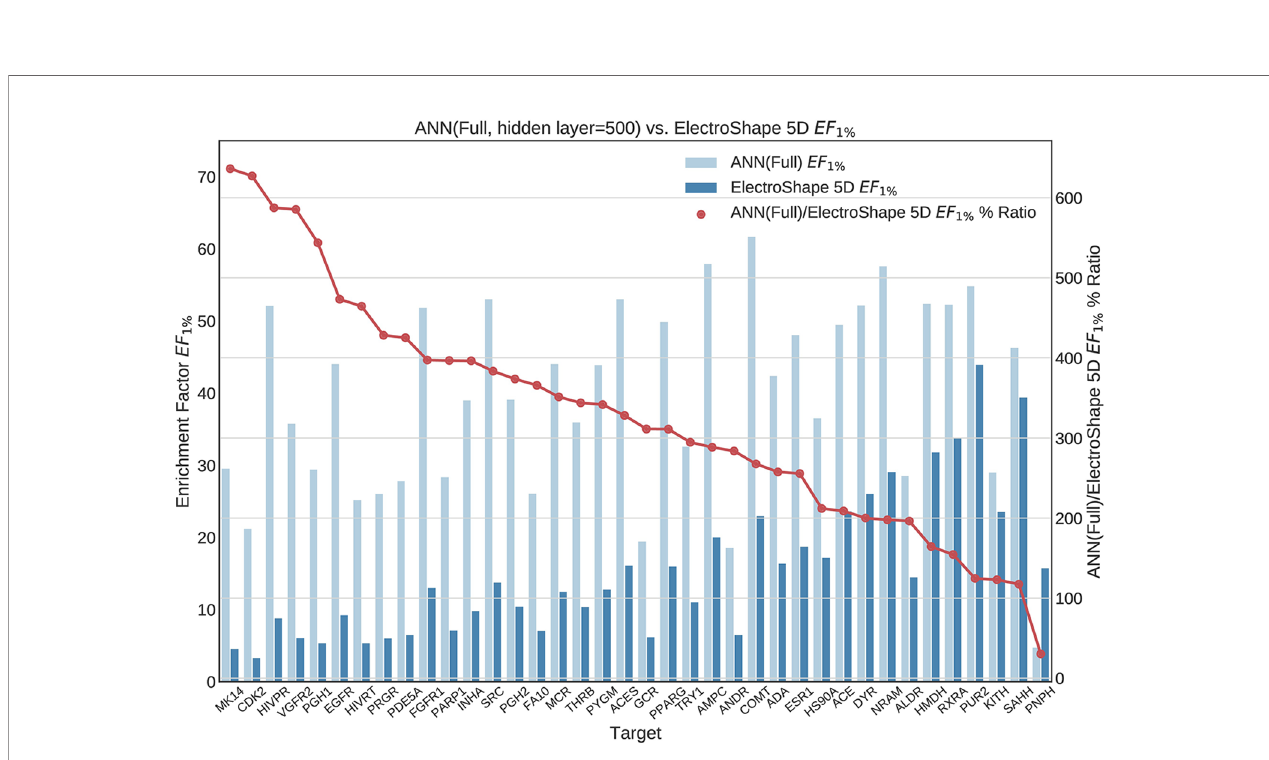
FIGURE 9 | Comparison of Enrichment Factor at 1% obtained by Arti fi cal Neural Networks with 500-node hidden layer with that obtained by ElectroShape 5D using full conformer models. Also plotted is the percentage ratio of the Enrichment Factor score of Arti fi cial Neural Network (ANN) compared to ElectroShape 5D. Mean ratio = 328% ± 149%, max = 636%, min =